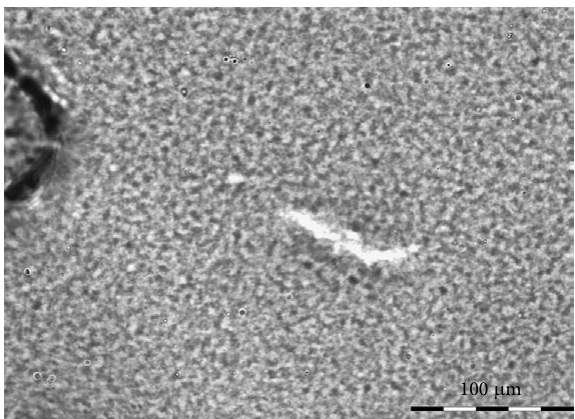
Fig. 2. Photographic recording of the E 160V55 film – rough surface of the hardened old dispersion film (50-fold magnification)